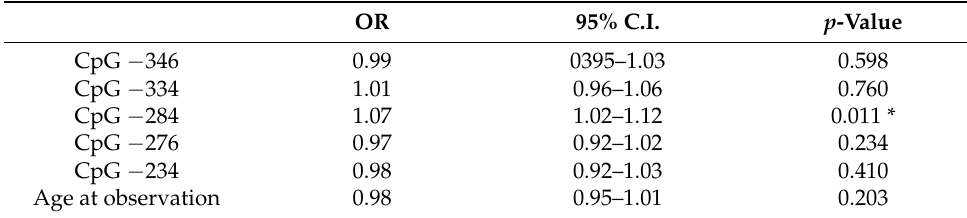
Table 3. Results from a multivariable logistic regression.